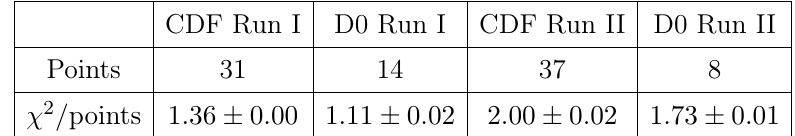
Table 8 . Number of points analyzed and (cid:31) 2 values for fixed-target Drell-Yan experiments at low energy. The labels in square brackets were introduced in section 3.2.